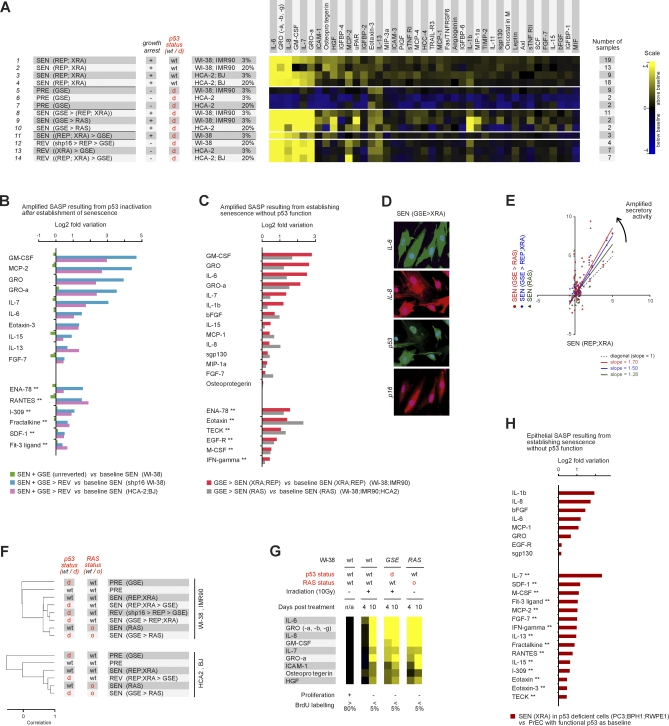
p53 Restrains the SASP(A) CM containing factors secreted by the indicted cells were analyzed by antibody arrays and displayed, using PRE CM as the baseline. We pooled data from cells of the same genotype (p53 wild type or p53 deficient) under the same culture conditions. SEN indicates pooled data from cells originating from the same tissue (WI-38, IMR-90 from embryonic lung; and HCA-2, BJ from neonatal foreskin) and induced to senesce by REP or XRA. Pooling and averaging of highly correlated samples was performed as described for Figure 5, and details of the data processing are provided in Datasets S13–S16. The top four rows are the same top four rows in Figure 5A and are included to serve as a visual reference. The senescence inducer is given in parentheses. p53 status is indicated as either wild type (wt) or deficient (d) owing to either GSE22 expression or expression of an shRNA against p53. Manipulations are indicated in sequence, separated by a greater than symbol (>). The heat map key (right) indicates the log2-fold changes. Signals higher than the baseline are shown in yellow; signals below baseline are displayed in blue. Comparison between rows is accurately illustrated in (B) and (C) in which each genetically manipulated cell type is compared to its appropriate control baseline.(B) Log2-fold values for SASP factors that are significantly increased, or significantly and uniquely (as indicated by double asterisks [**]) elevated, in CM from SEN cells made p53 deficient by GSE22, using untreated wild-type SEN values as the baseline. Green indicates WI-38 cells made senescent by XRA, after which p53 was subsequently inactivated by expressing GSE22 using a lentivirus; these cells do not resume proliferation (“unreverted”) upon p53 inactivation (see Figure S6). Blue indicates WI-38 in which p16 was inactivated by an shRNA, induced to senesce by XRA, then infected with the GSE22-expressing lentivirus; these cells do revert (REV) after p53 inactivation. Pink indicates HCA2 cells made SEN by XRA, then infected with GSE22 lentivirus; these cells also revert after p53 inactivation.(C) Log2-fold values for SASP factors that are significantly increased, or significantly and uniquely (as indicated by double asterisks [**]) elevated, in CM from cells made p53-deficient (by GSE22 expression), then induced to senesce by REP, XRA, or RAS. Red indicates WI-38 and IMR90 (averaged) cells expressing GSE22, then induced to senesce by XRA or REP, using cells made SEN by XRA or REP as a baseline. Gray indicates WI-38, IMR-90, and HCA2 (averaged) expressing GSE22, then made senescent by RAS, using SEN by RAS as a baseline.(D) WI-38 cells expressing GSE22 were induced to senesce by XRA and then immunostained for the SASP proteins IL-6 and IL-8, the senescence marker p16INK4a, and p53, which accumulates in the presence of GSE22.(E) Comparative graphical representation of the secretory profiles of cells made senescent by XRA or REP (dotted line), RAS (black line), p53 inactivation (GSE22) followed by XRA or REP (blue line), or p53 inactivation (GSE22) followed by RAS (red line). The increased slopes (as indicated by the arrow)indicate amplified SASPs.(F) Hierarchical cluster analysis of all the cells analyzed in (A), plus the SASP induced by RAS (see Figure 5). RAS status is indicated as either wild type (wt) or oncogenic (o) owing to expression of Ha-RASv12.(G) WI-38 cells with wild-type (wt) or inactive (GSE) p53 were irradiated or induced to express oncogenic RAS (RAS), and CM was collected 4 or 10 d later. Soluble factors were analyzed by antibody arrays and displayed as described in Figure 1D, using PRE CM as the baseline (black column on the left; see also Figure S5C for details). Signals higher than baseline are shown in yellow; signals below baseline are in blue. n/a, not applicable.(H) Log2-fold values for prostate epithelial cell SASP factors that are significantly or uniquely (as indicated by double asterisks [**]) elevated in CM from p53-deficient cancer cells (PC3, BPH1, and RWPE1) that were induced to senesce by XRA, compared to primary p53 wild-type cells (PrECs) that were induced to senesce by XRA.